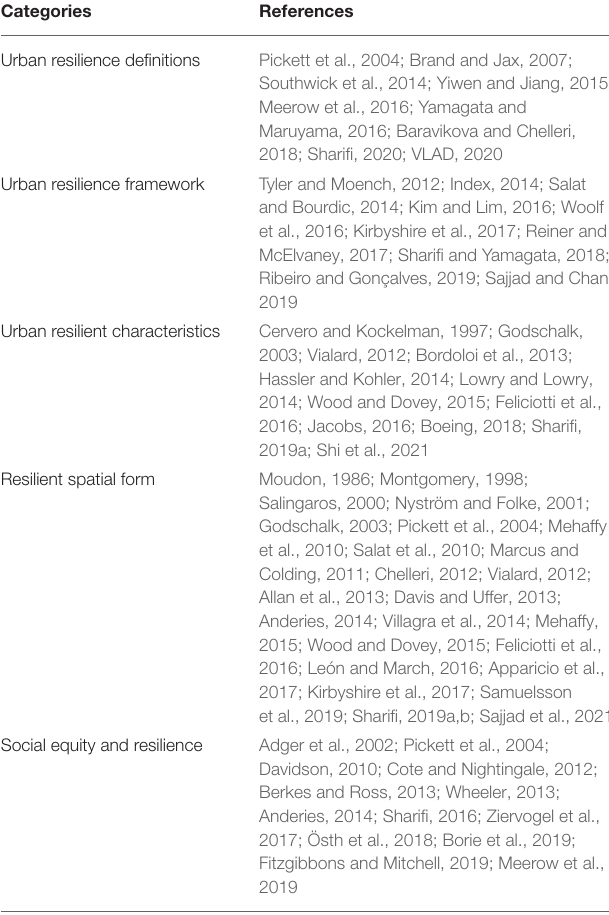
TABLE 1 | A list of the literature on urban resilience classified by subject